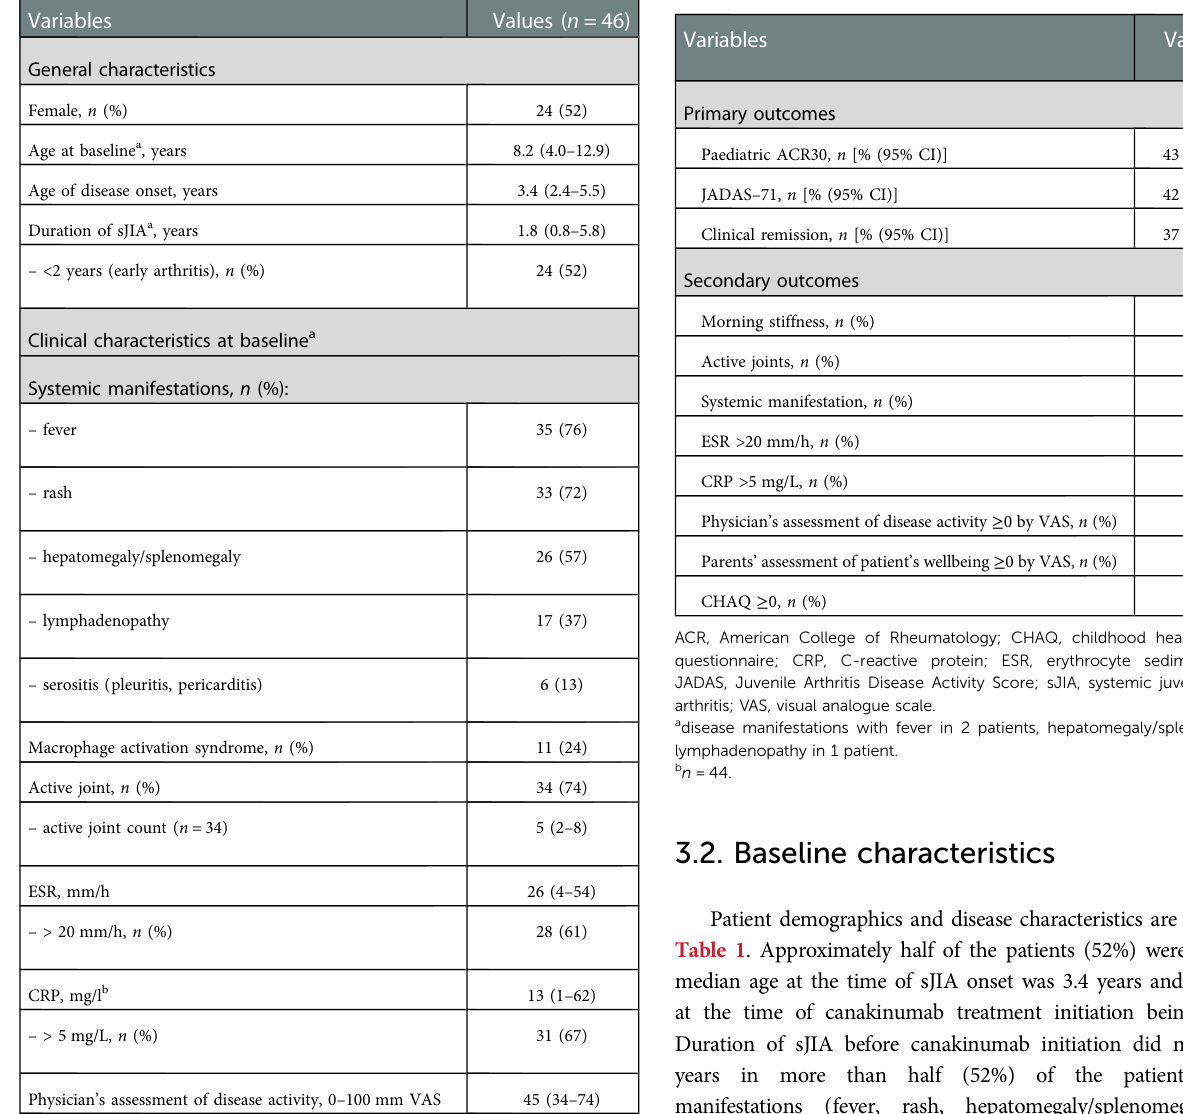
TABLE 2 Treatment outcomes after 12 months or the closest follow-up time (not less than 6 and not more than 18 months) after the fi rst dose of canakinumab.